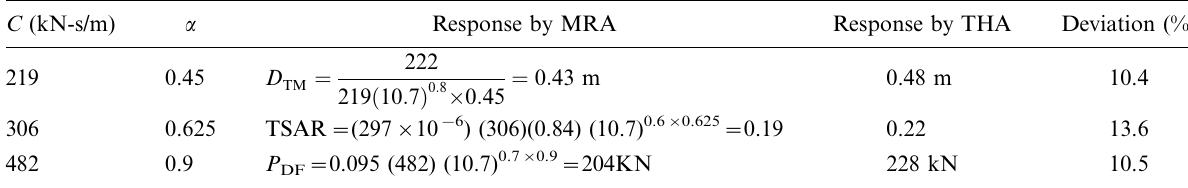
Table 12. VFD system property combinations and corresponding responses using MRA C